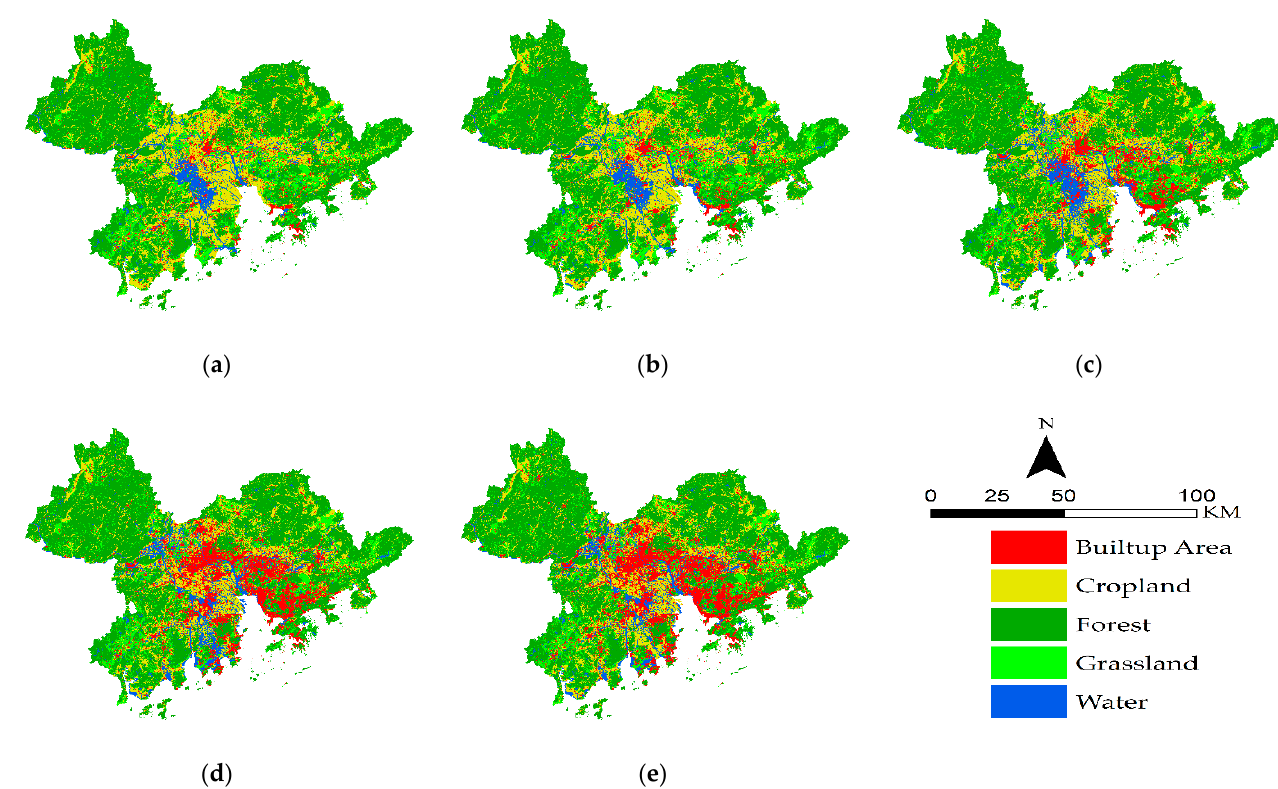
Figure 3 . GBA LULC maps ( a ) 1980, ( b ) 1990, ( c ) 2000, ( d ) 2010, and ( e ) 2020. Figure 3. GBA LULC maps ( a ) 1980, ( b ) 1990, ( c ) 2000, ( d ) 2010, and ( e )